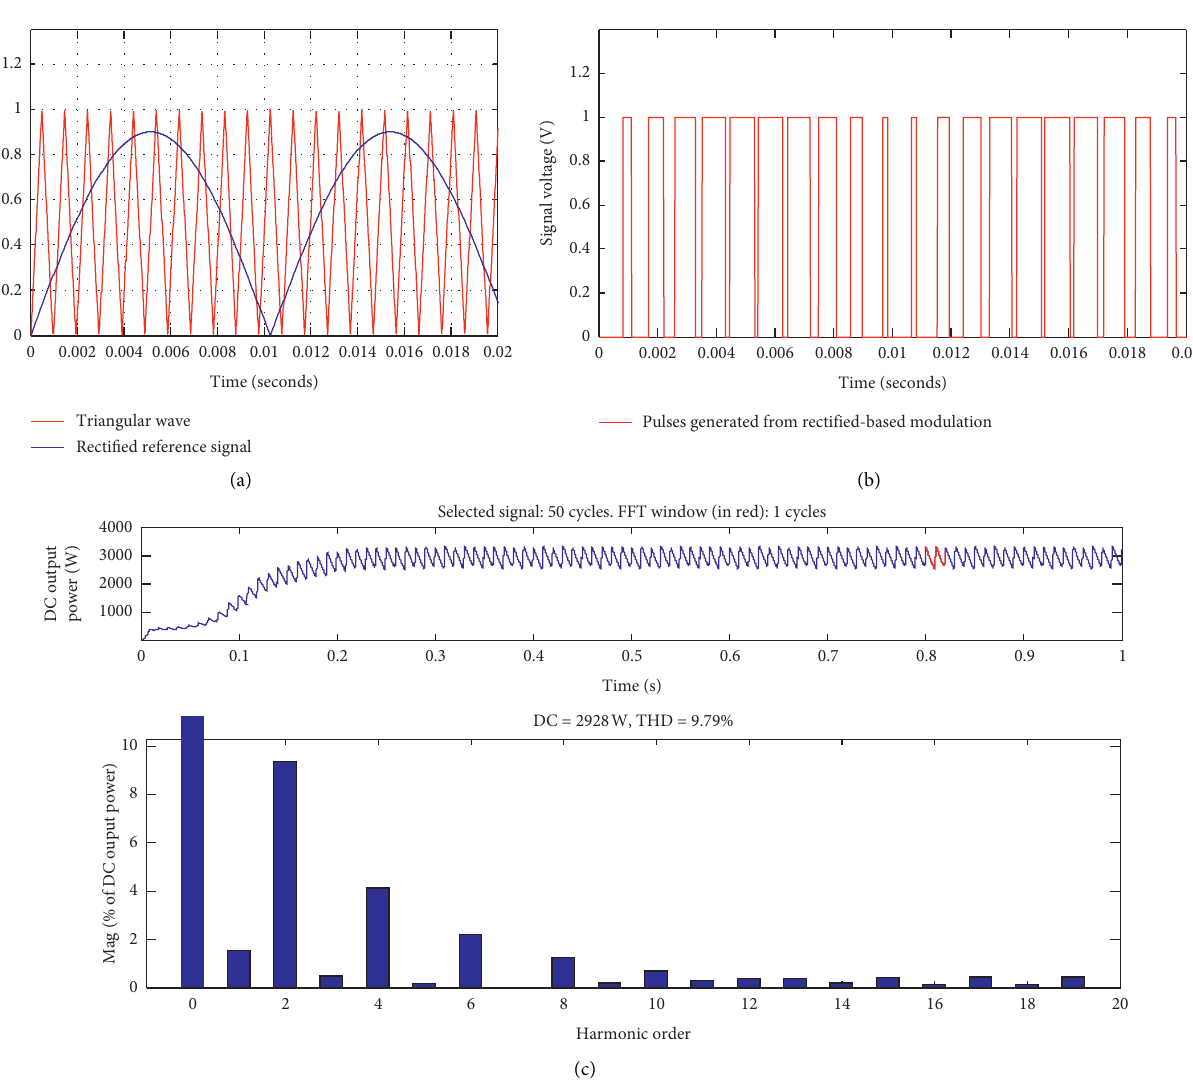
Figure 1: (a) RTMS. (b) Firing pulses of RTMS. (c) Spectral analysis of the output power of boost DC-DC converter using RTMS.